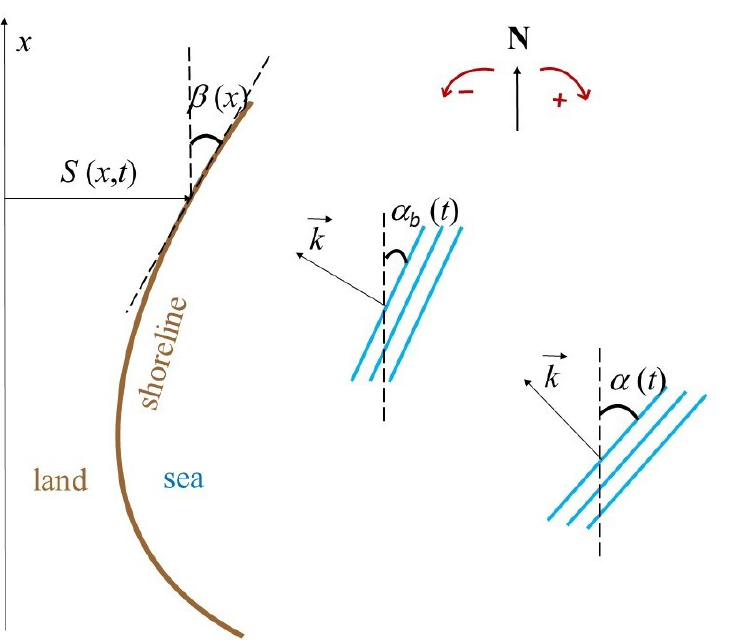
Figure 1. Plan view of the incident wave orientation angle α and the beach orientation angle β . From the vertical line, an angle measured clockwise is positive and an angle measured counterclock- wise is negative. α b denotes the breaking wave angle. S denotes the shoreline position with respect to an arbitrary vertical baseline. (cid:126) k is the wave vector. N stands for the